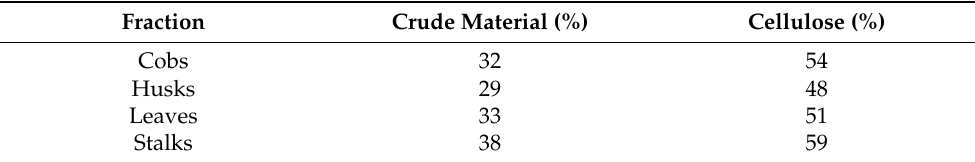
Table 2. The degree of crystallinity of maize stover fractions and cellulose isolated from these fractions.